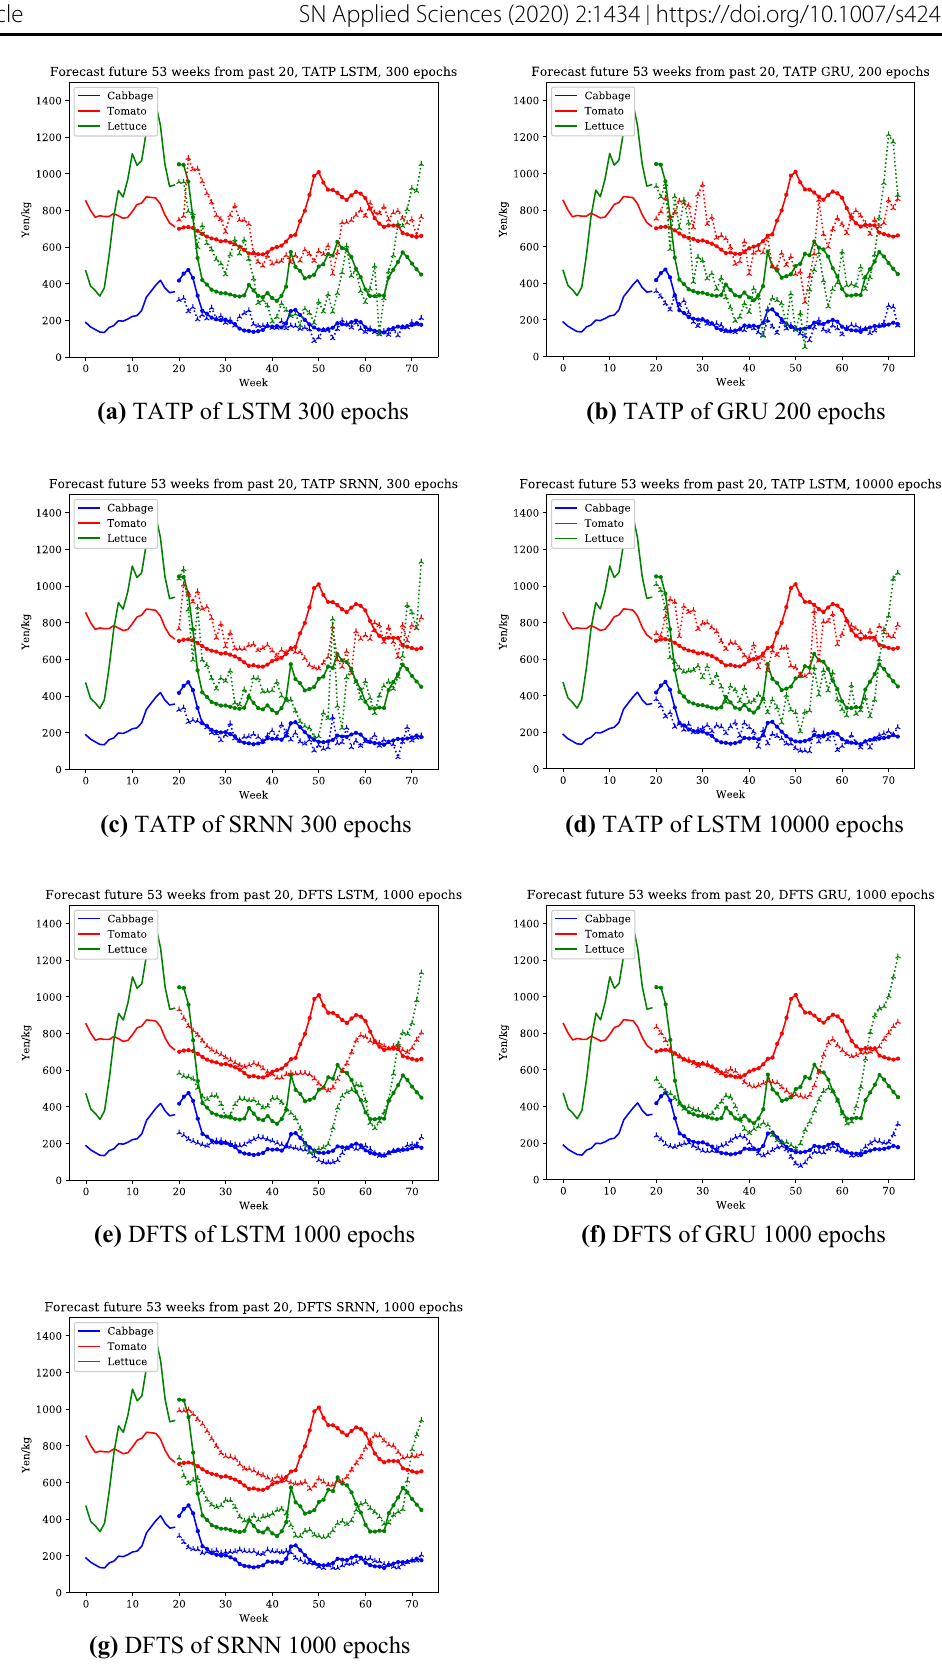
Fig. 3 Forecasted prices 53 weeks into the